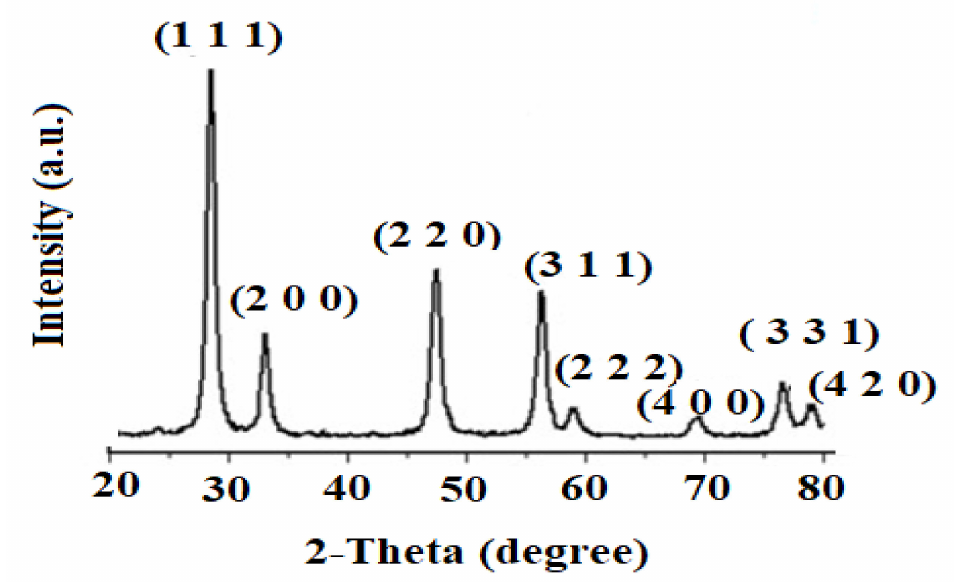
Figure 3. Spectrum of X-ray Diffraction Spectroscopy (XRD) showing the crystal planes corresponding to the crystallite phase CeO 2